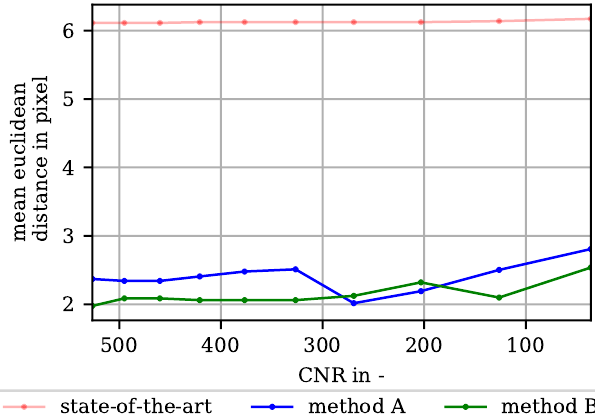
Figure 11. Mean euclidean distance between the true and the evaluated transition lines of the state-of-the-art image processing (red), method A (blue), and method B (green) over the CNR between the turbulence wedge and the surrounding laminar flow regime. The relative contrast of the turbulence wedge is c wed = 50%. The mean euclidean distance of method A and B increases with increasing noise but remains below the state-of-the-art method. This proves that the introduced image processing is robust towards even low